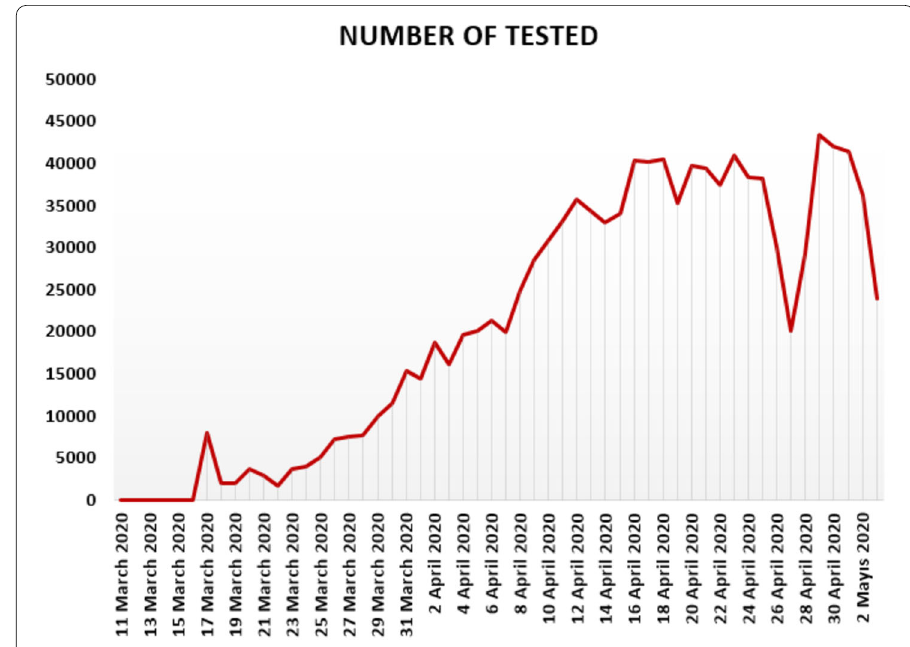
Figure 10 Number of tested people in Turkey from 11 March 2020 to 3 May 2020